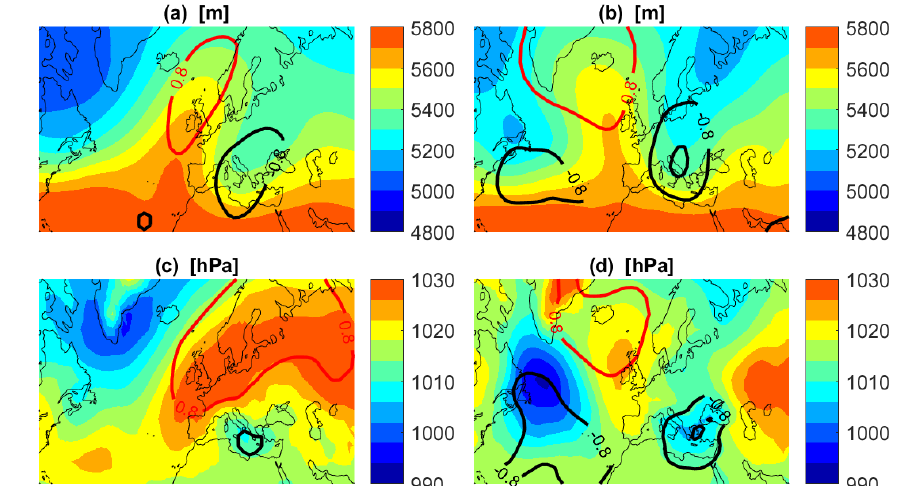
Figure 2. Dynamics for clusters of cold spells over Italy: 500hPa geopotential height [m] (a, b) and sea-level pressure [hPa] (c, d) averaged over the two clusters of cold spells in Italy found via k means. Cluster 1 (a, c) is characterized by zonally tilted high pressure located between the British Isles and Russia and cluster 2 (b, d) by an omega-blocking pattern between the Atlantic and Europe. Black and red isolines represent negative and positive standardized